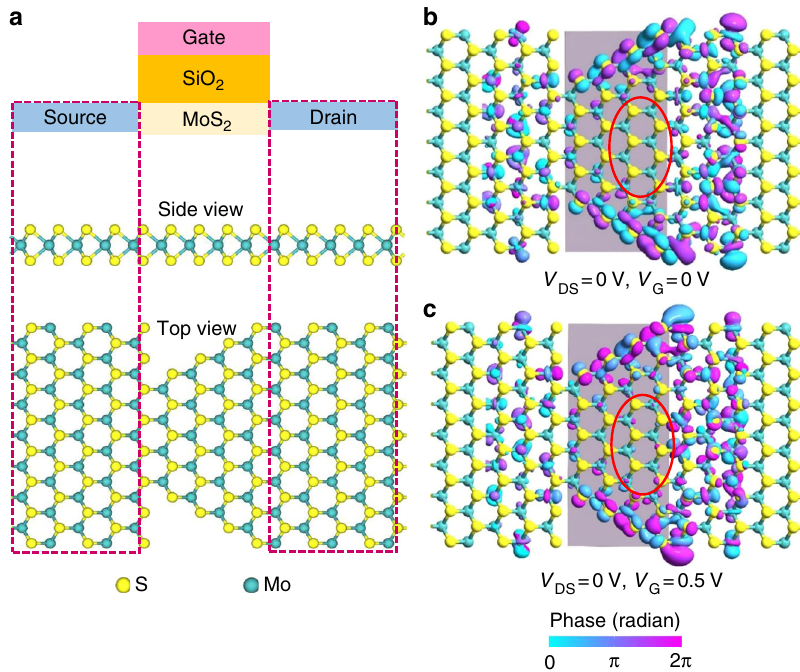
Fig. 3 Calculations of charge transport on edge state of monolayer MoS 2 . a Schematic of monolayer MoS 2 FET (Uppermost row); side view (Middle row) and top view (Lowest row) of monolayer MoS 2 . The isosurface plots for transmission eigenstates of the MoS 2 channel at the k-point Γ (0,0) and the energy of 0.05eV under the conditions of V DS = 0V and V G = 0V in b , and V DS = 0V and V G = 0.5V in c . The evolving of the carriers in bulk is revealed as highlighted by the red ellipse in b and c , although only a small gate voltage (0.5V) is applied in